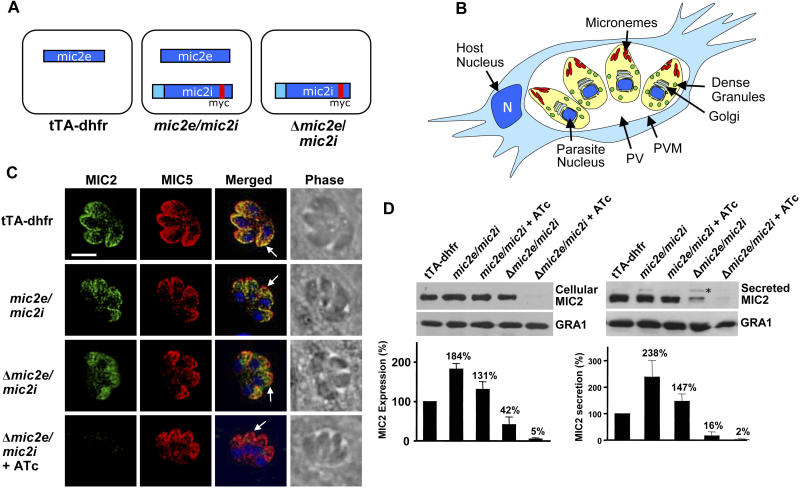
Conditional Expression of MIC2(A) Schematic diagram showing the strains in the study, including the parental strain (tTA-dhfr), and the mic2e/mic2i strain with both endogenous (mic2e) and induced (mic2i) copies of mic2. A knockout of mic2e leaves the regulatable mic2i in Δmic2e/mic2i.
(B) Illustration of intracellular structures including the micronemes, dense granules, Golgi, PV, PV membrane, and host and parasite nuclei in a four-parasite vacuole.(C) Expression and localization of MIC2 (green) in intracellular parasites with another micronemal marker MIC5 (red). Arrows indicate the apical pole of parasites. Scale bar, 5 μm.(D) Western blot analyses showing MIC2 steady-state expression (left blot) and secretion (right blot) levels. Asterisk indicates the full-length myc-tagged MIC2, which is secreted in mic2e/mic2i and Δmic2e/mic2i parasites based on probing with a myc antibody (unpublished data). Blots were probed with anti-MIC2 6D10 (top blots) and mouse anti-GRA1 (bottom blots), a dense granule protein, to normalize loading in all lanes. The bar graphs represent the relative percentages of MIC2 expressed in each strain and treatment compared to the reference tTA-dhfr level (100%) quantified from direct chemiluminescent imaging. Results are mean ± s.e.m, n = 3.